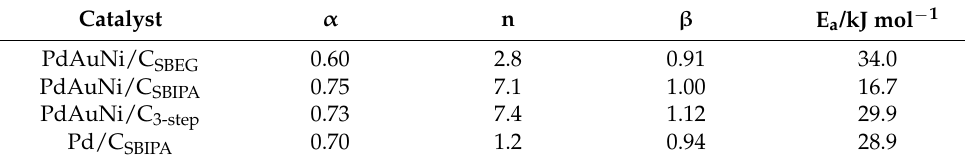
Table 4. Kinetic parameters for BOR at the four studied